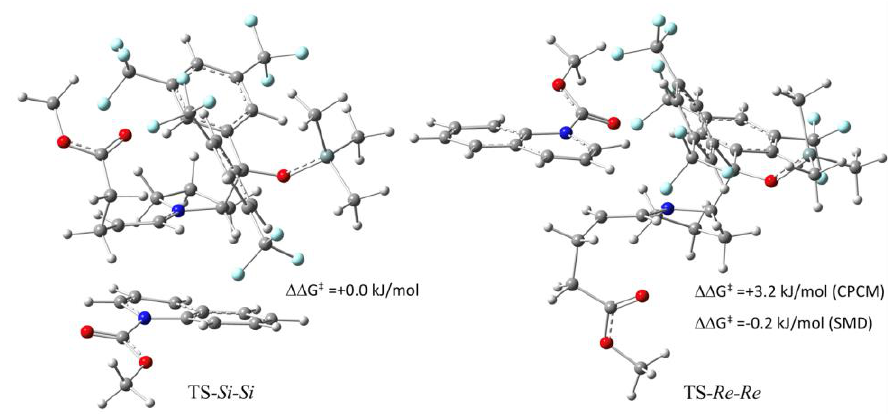
Figure 2. Transition states (TS) leading to ( R , R )- 3ab and ( S , S )- 3ab , respectively, using organocatalyst L 2